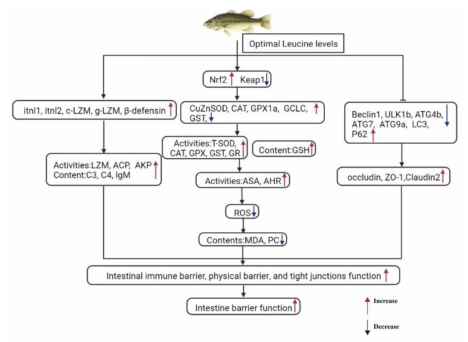
Figure 5. The potential pathways regarding the effects of Leu on the intestinal immune barrier, physical barrier, and tight junction function of fish. Abbreviations: itnl1 = intelectin 1; itnl2 = intelectin 2; c-LZM = c-type lysozyme; g-LZM = g-type lysozyme; Nrf2 = nuclear factor erythroid 2-related factor 2; Keap1 = Kelch-like ECH-associated protein 1; CuZnSOD = copper–zinc superoxide dismutase; CAT = catalase; GPX1a = lutathione peroxidase 1a; GST = glutathione S-transferase; GCLC = catalytic subunit of glutamate–cysteine ligase; ULK1b = uncoordinated 51-like kinase 1b; ATG5 = autophagy- related protein 5; ATG7 = autophagy-related protein 7; ATG9a = autophagy-related protein 9a; ATG4b = autophagy-related protein 4b; LC3b = autophagy marker light-chain 3b; P62 = sequestosome 1; ZO-1 = zonula